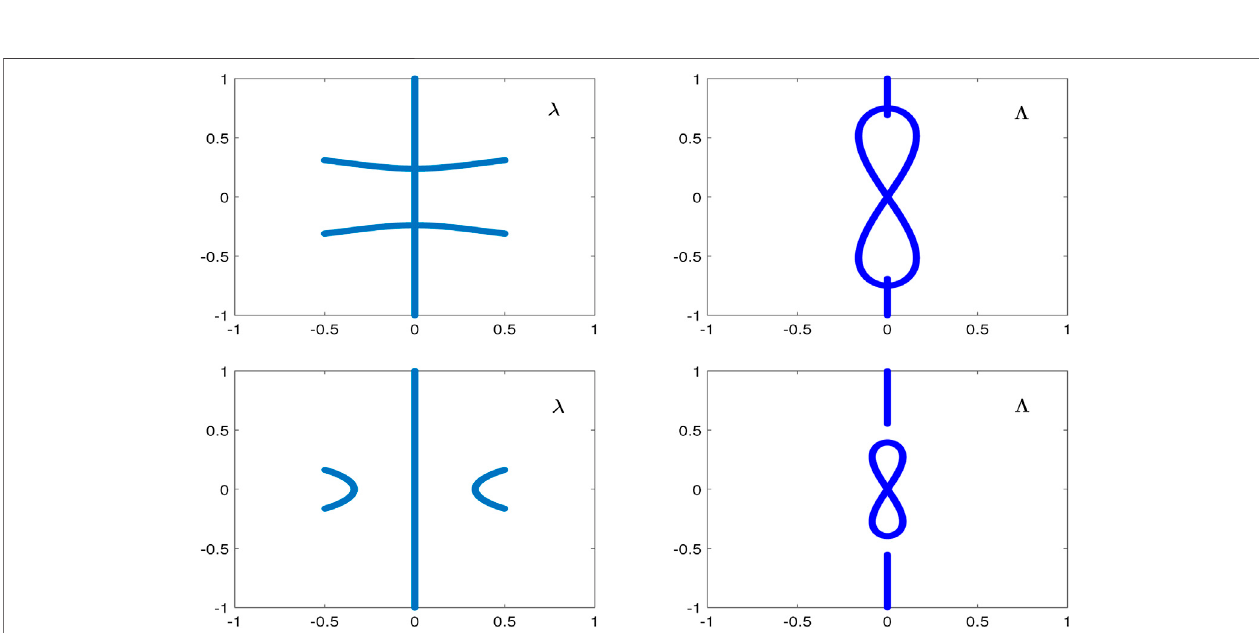
FIGURE 3 | The same as Figure 2 but for the amplitude-normalized cn-periodic wave with k (cid:2) 0 . 85 (top) and k (cid:2) 0 . 95 (bottom) .